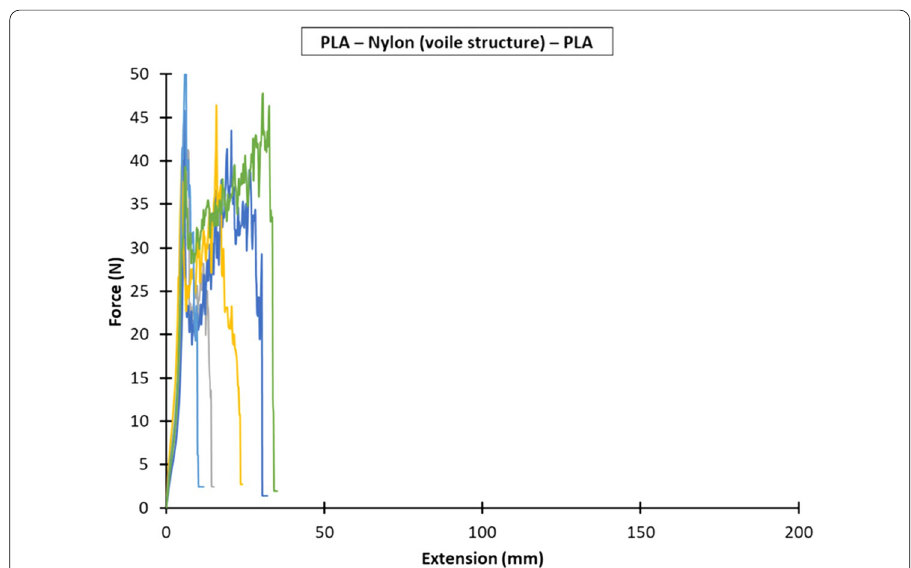
Fig. 9 Force versus extension plots for six specimens with the PLA—Nylon (voile structure)—PLA orientation